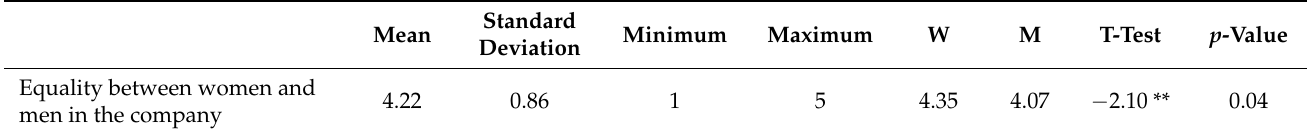
Table A5. Descriptive statistics and mean comparison between women and men who responded to P35—Considering the following topics, please indicate, on a scale from 1 = Not Important to 5 = Very Important, to what extent you consider it is important to have a balanced representation of